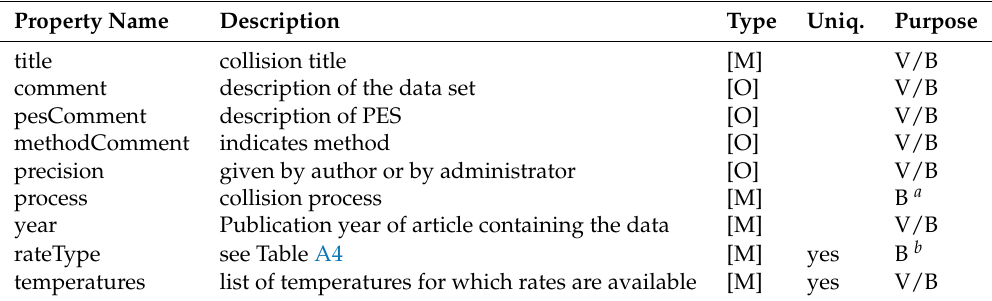
Table 4. List of properties/metadata for the object “Rate Coefficients”. The symbols [M] and [O] indicate that the metadata are either mandatory or optional in the import file. In the column “Uniq.”, we indicate whether the metadata defines the uniqueness of the object. In the column “Purpose”, we indicate whether the information is meant for the BASECOL (B) public WebUI display and/or for VAMDC (V) interoperability. The unit of “temperatures” is